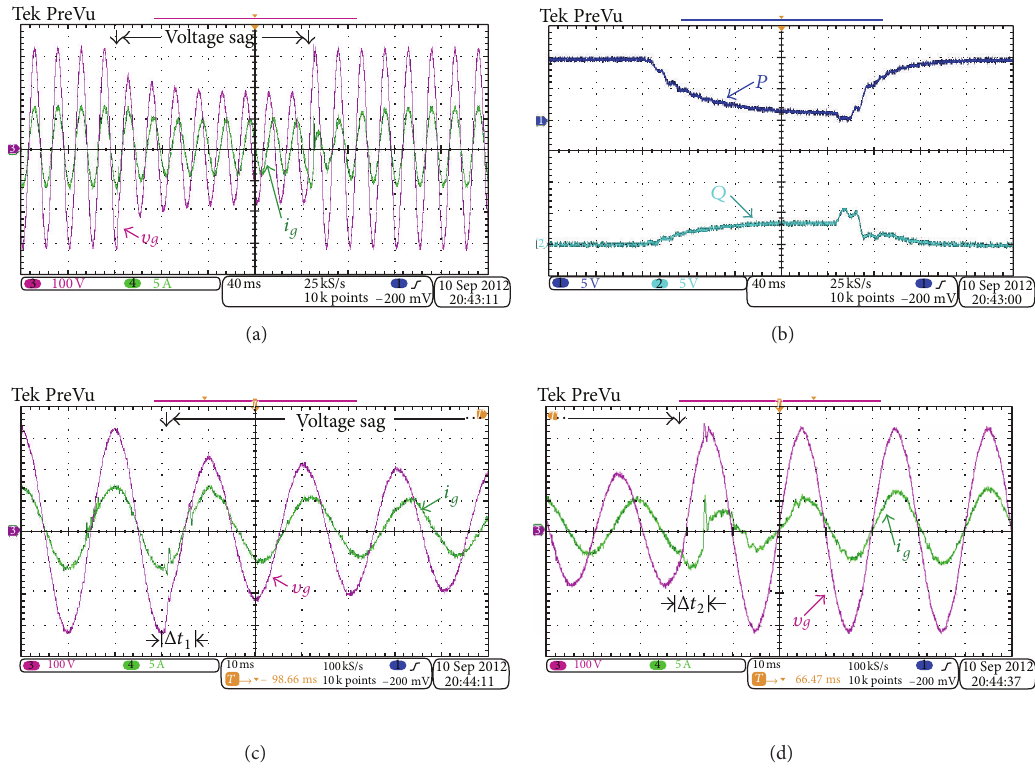
Figure 15: Experimental results of a single-phase system under grid fault based on the single-phase 𝑃𝑄 theory and T /4 Delay sag detection method: (a) grid voltage 𝑣 𝑔 : 100V/div and grid current 𝑖 𝑔 : 5 A/div; (b) active power 𝑃 : 500 W/div and reactive power 𝑄 : 500 Var/div; (c) dynamic performance of grid voltage and current at the start of sag; (d) dynamic performance of grid voltage and current at the end of